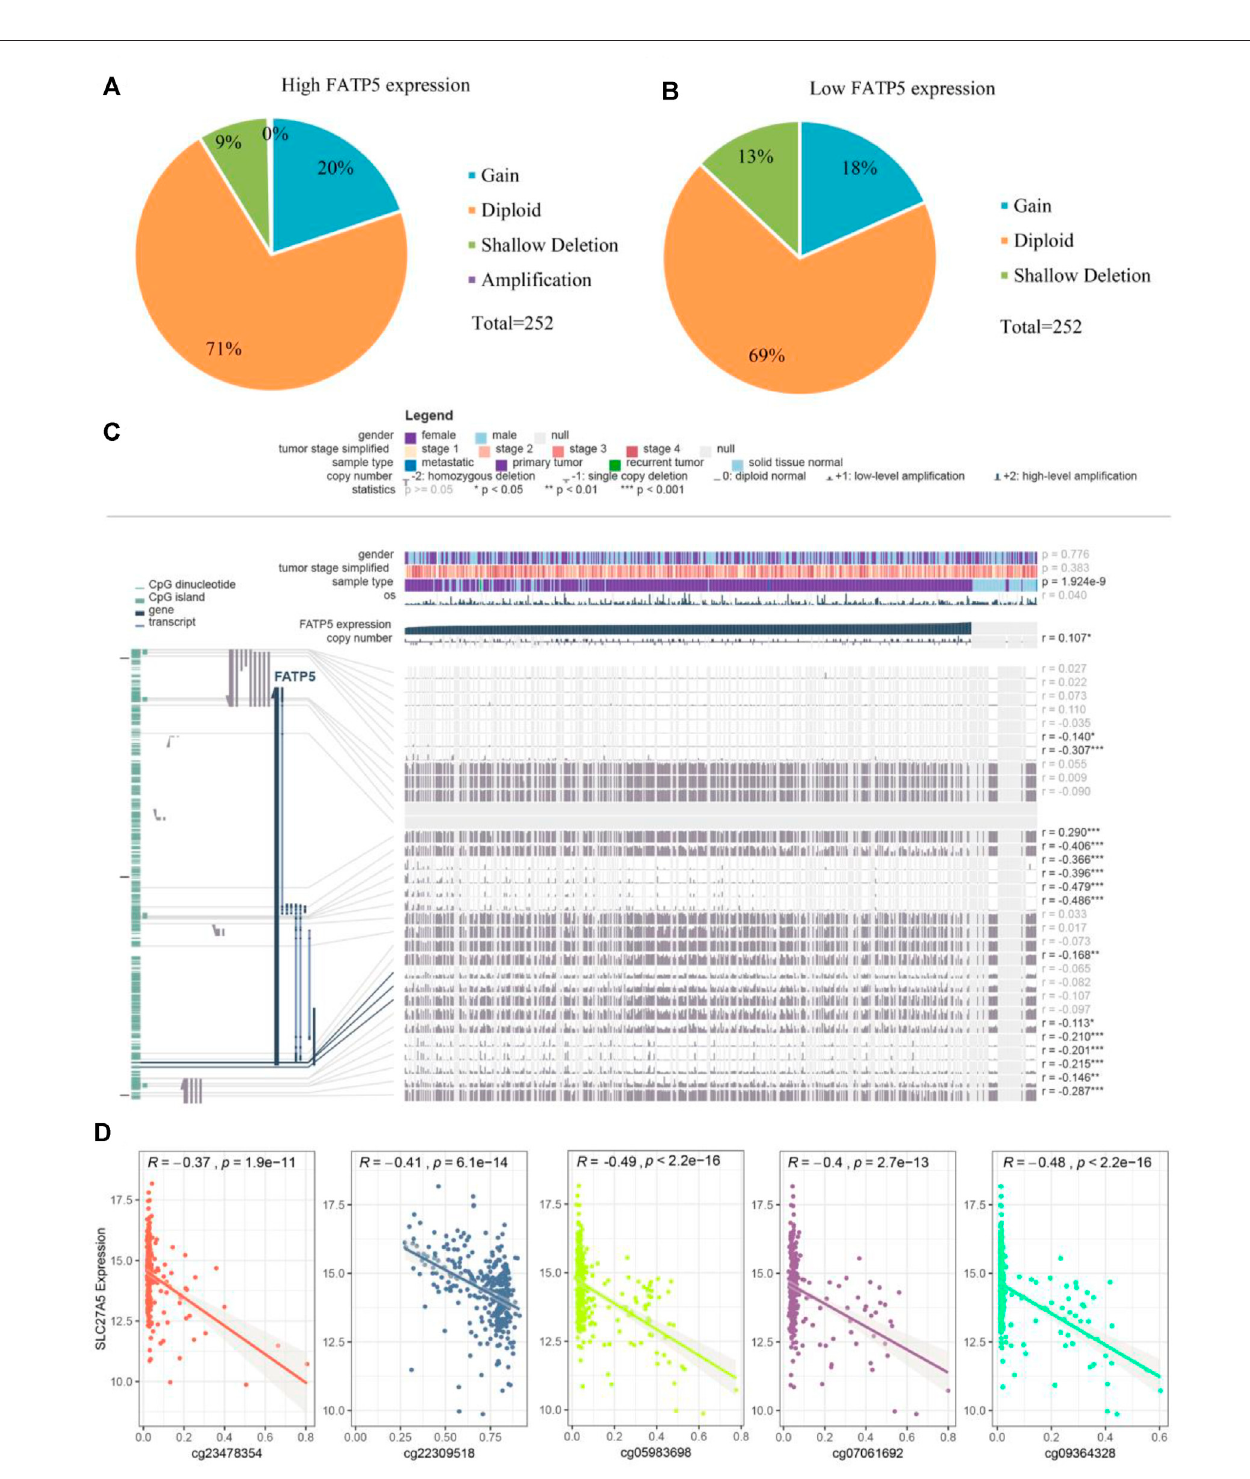
FIGURE 4 | Analysis of the potential genetic and epigenetic alterations associated with FATP5 dysregulation. (A,B) The CNAs in FATP5-high and low expression groups. (C) Analysis of CpG island methylation and abnormal FATP5 expression using TCGA dataset. (D) Correlation between FATP5 expression and CpG island methylation was performed. *** p <